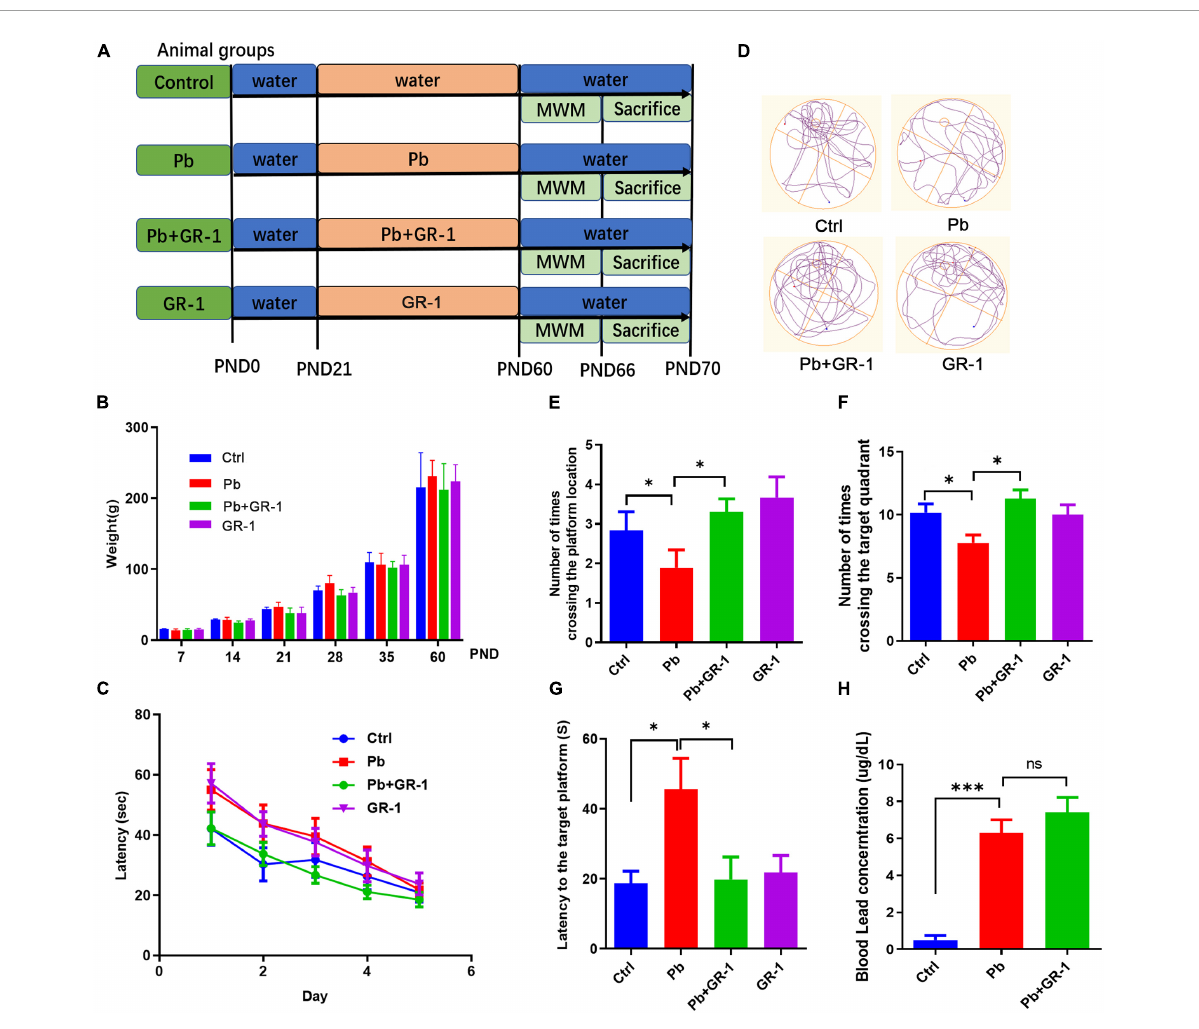
FIGURE1 Administration of Lactobacillus rhamnosus GR-1 alleviated Pb-induced learning and memory deficits. (A) Scheme of treatment and behavioral tests in 8-month-old SD rats receiving sham or Lactobacillus rhamnosus GR-1 by gavage daily from postnatal day 21 (PND 21) to PND 60. (B) The weight of the rats was recorded throughout the trial period. (C) The escape latencies of the four groups over five consecutive training days. (D) Representative swimming paths of Ctrl ( n = 9), Pb ( n = 9) or Pb + GR-1 ( n = 9), and GR-1 ( n = 9) on the test day. (E–G) Average crossing number over the platform-site (E) , number of times crossing the target quadrant (F) , and latency of the first target-site crossover during the test day (G) . (H) The blood Pb concentration of the indicated groups. Data are shown as mean ± SEM. ∗ p < 0.05, ∗∗∗ p < 0.001.